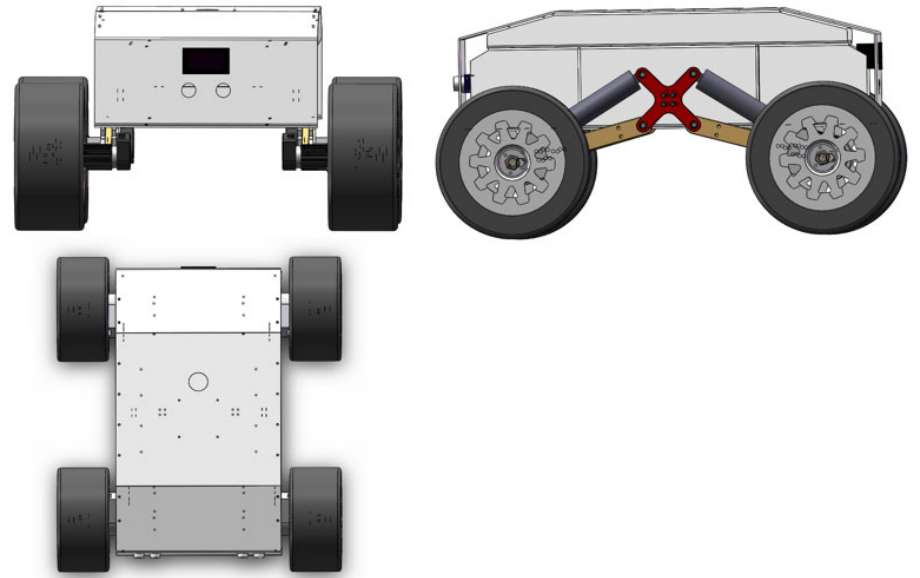
Figure 1. Four ‐ wheel adaptive robot model. Figure 1. Four-wheel adaptive robot model.